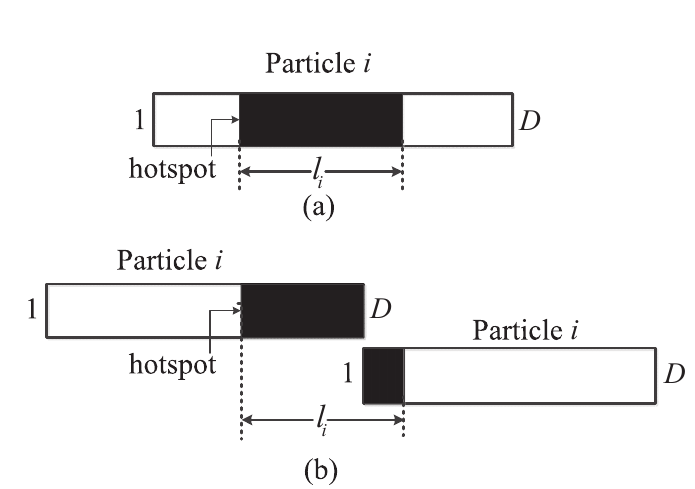
Figure 2: Determine mutation region in different situation. (a) the length after the hotspot is longer than l i . (b)the length after the hotspot is shorter than l